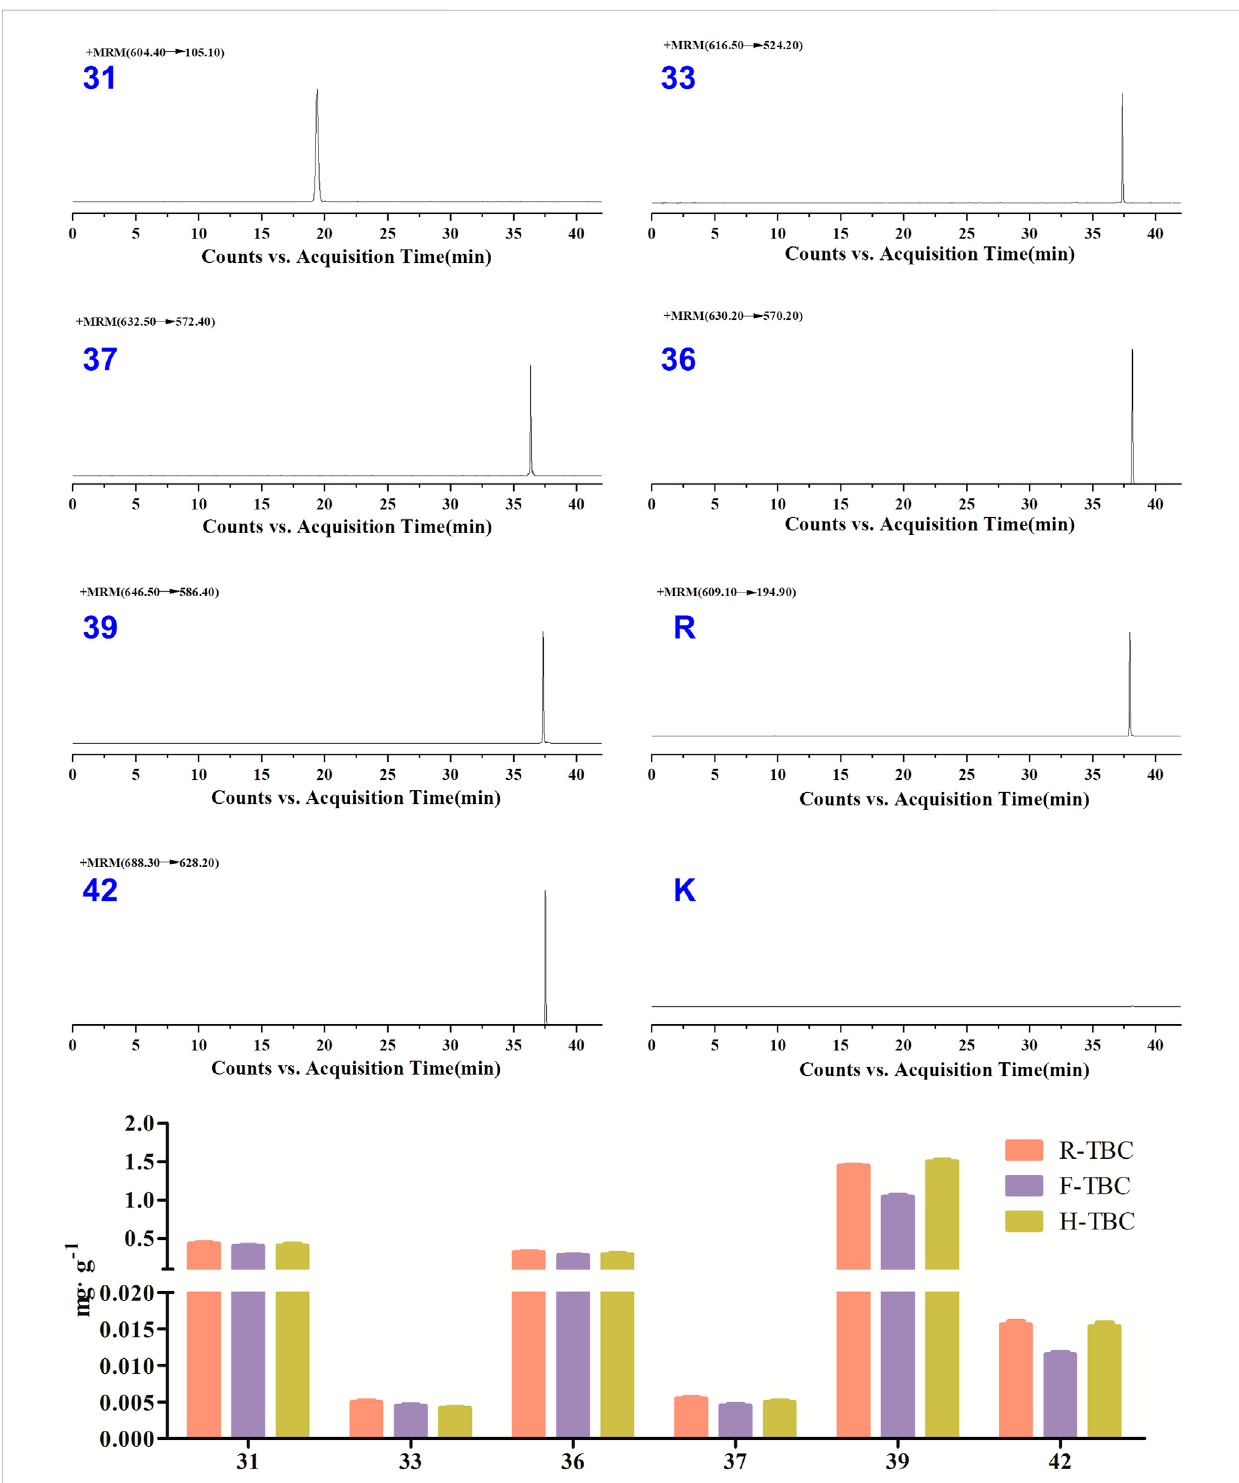
FIGURE 3 HPLC – QqQ – MS EIC of the 6 reference standard compounds, internal standard (reserpine, R) and blank solvent (B).